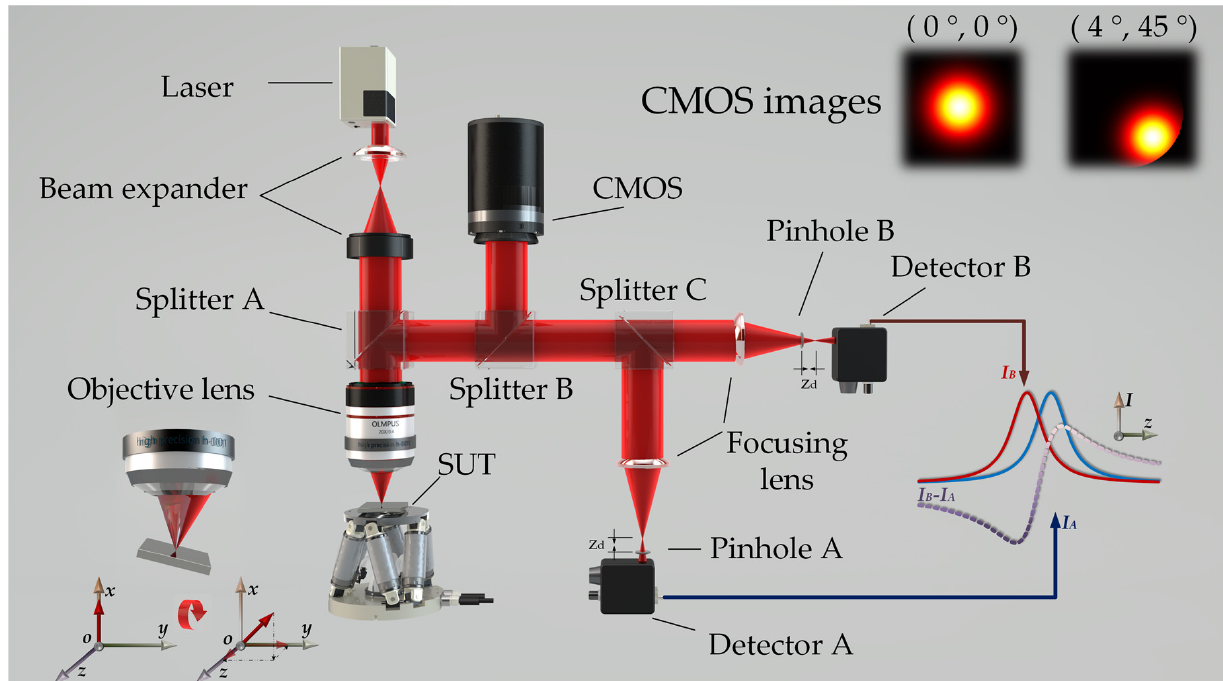
Figure 1. Diagram of the slope measurement sensor based on the differential confocal method showing the intensity distribution of the return beam spot detected by the detector when the measured plane is tilted.